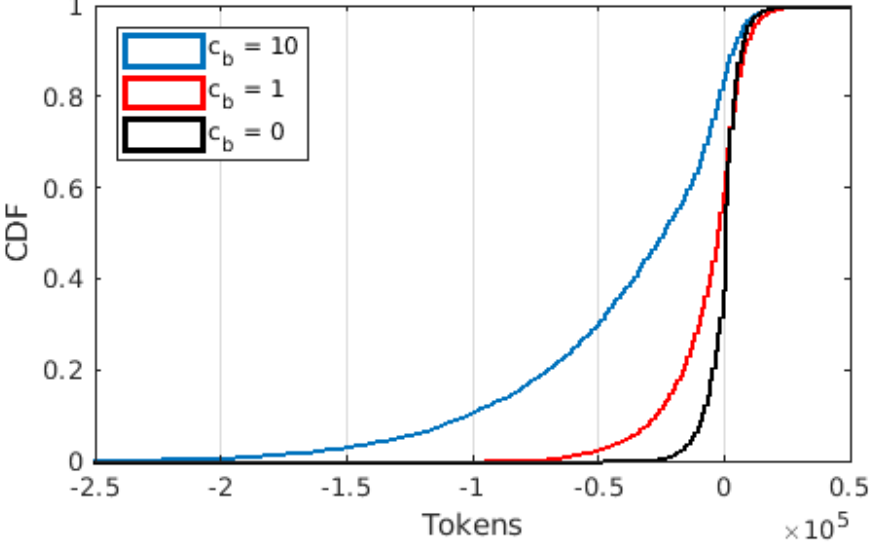
Figure 2. Cumulative Distribution Function of token balance for different values of c b